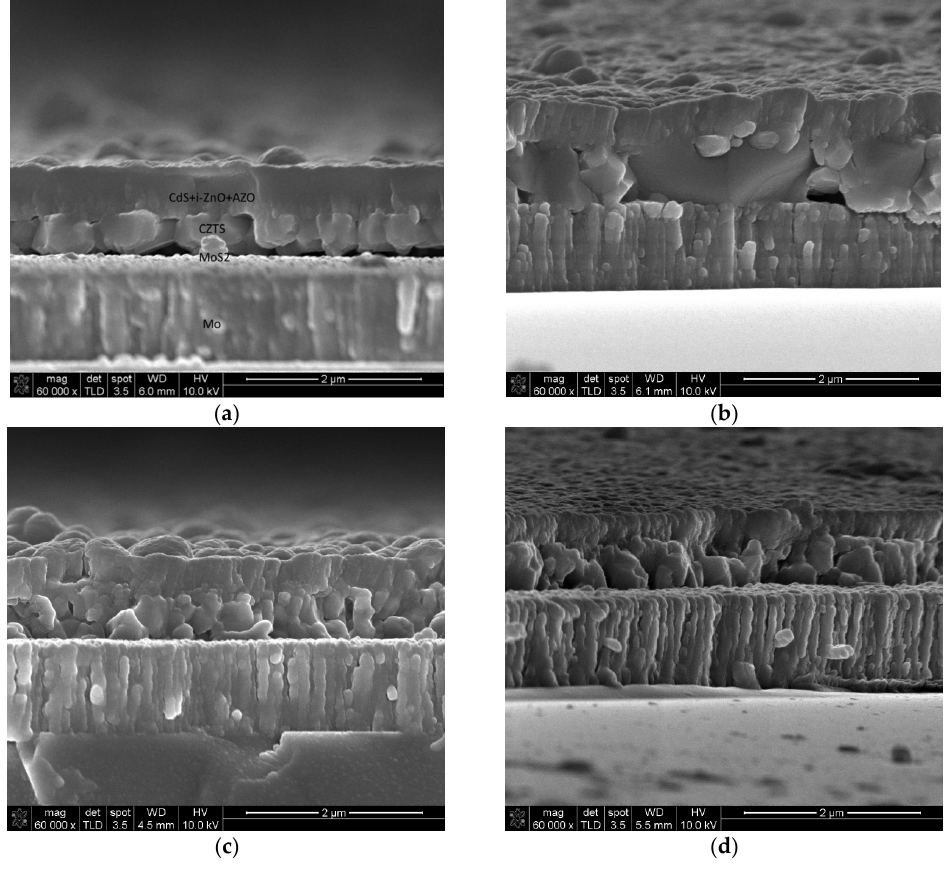
Figure 2. SEM cross section images of CZTS absorbers prepared from different precursors: